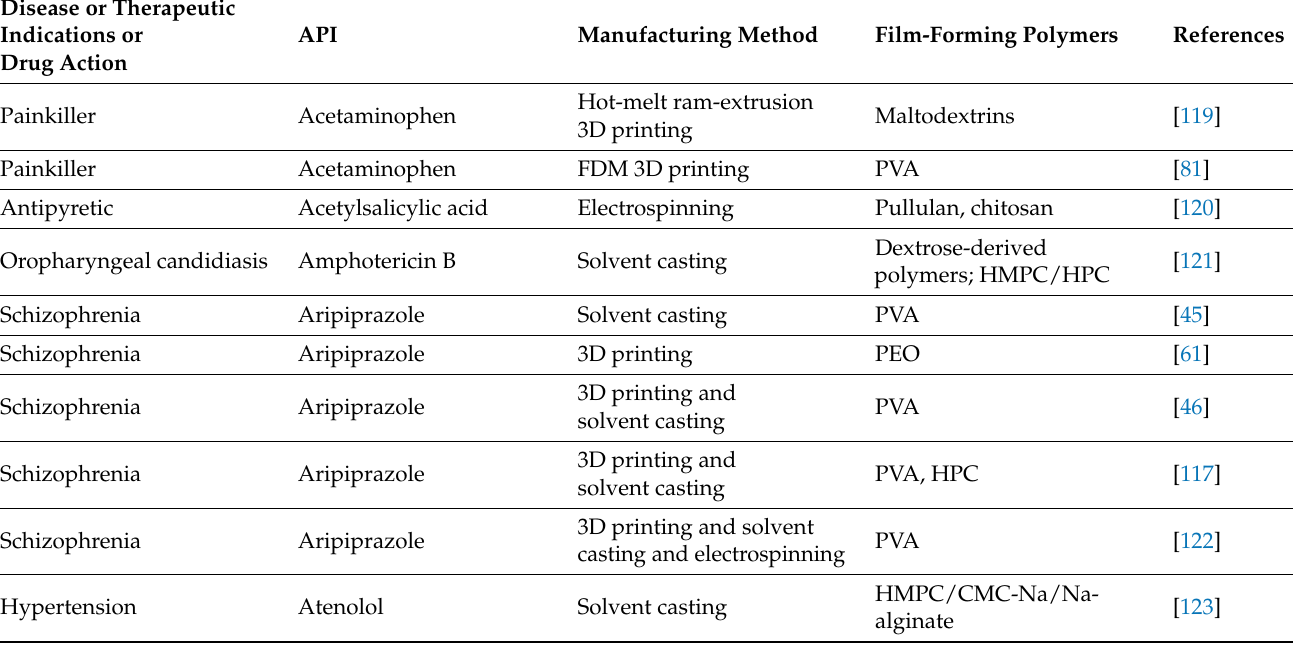
Table 1. Recent ODFs publications and utilized